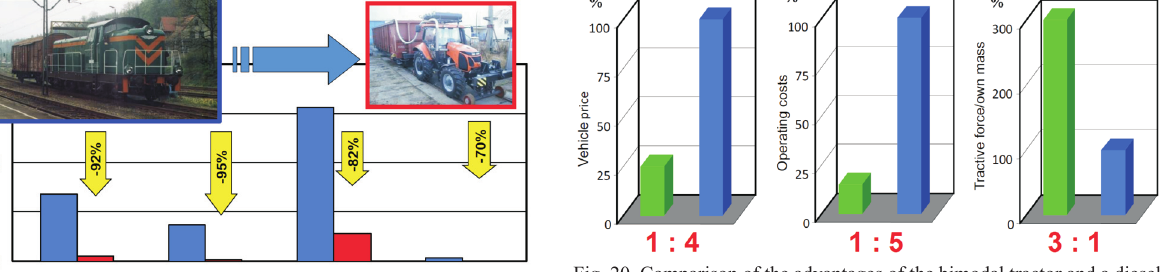
Fig. 20. Comparison of the advantages of the bimodal tractor and a diesel shunting